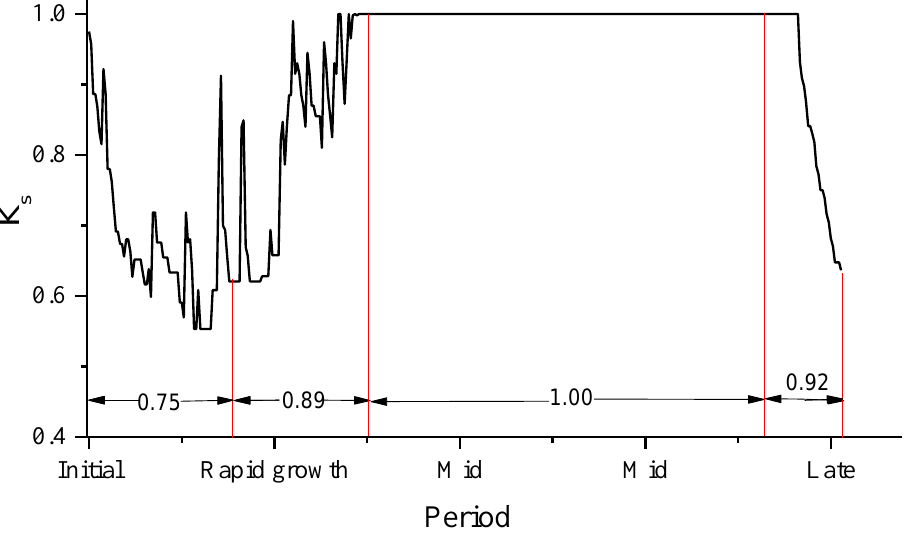
Figure 6. The soil water stress coefficient ( K s ) of rubber plantations.